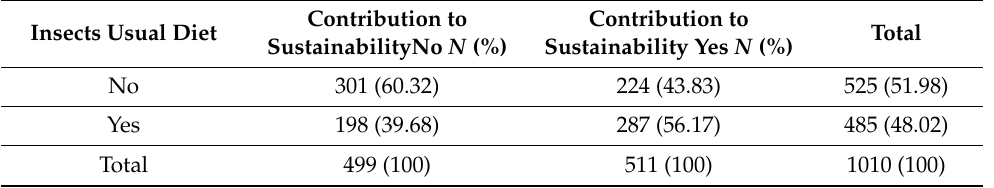
Table 3. Relationship between willingness to include insects in the usual diet and willingness to include them knowing that doing so has the potential to be a sustainable practice. Insects Usual